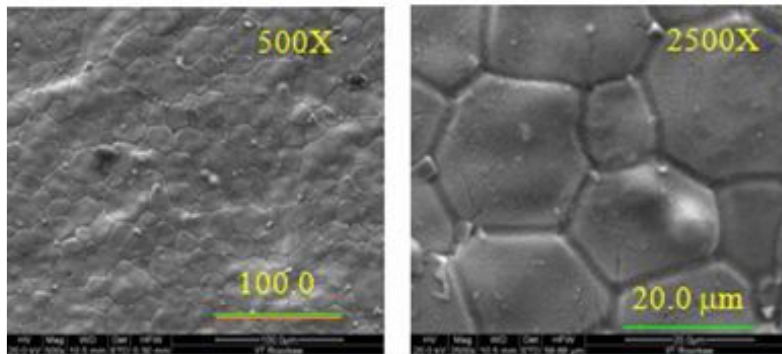
Figure 6. SEM and EDS analysis of CSZ with 12 mol% CaO.